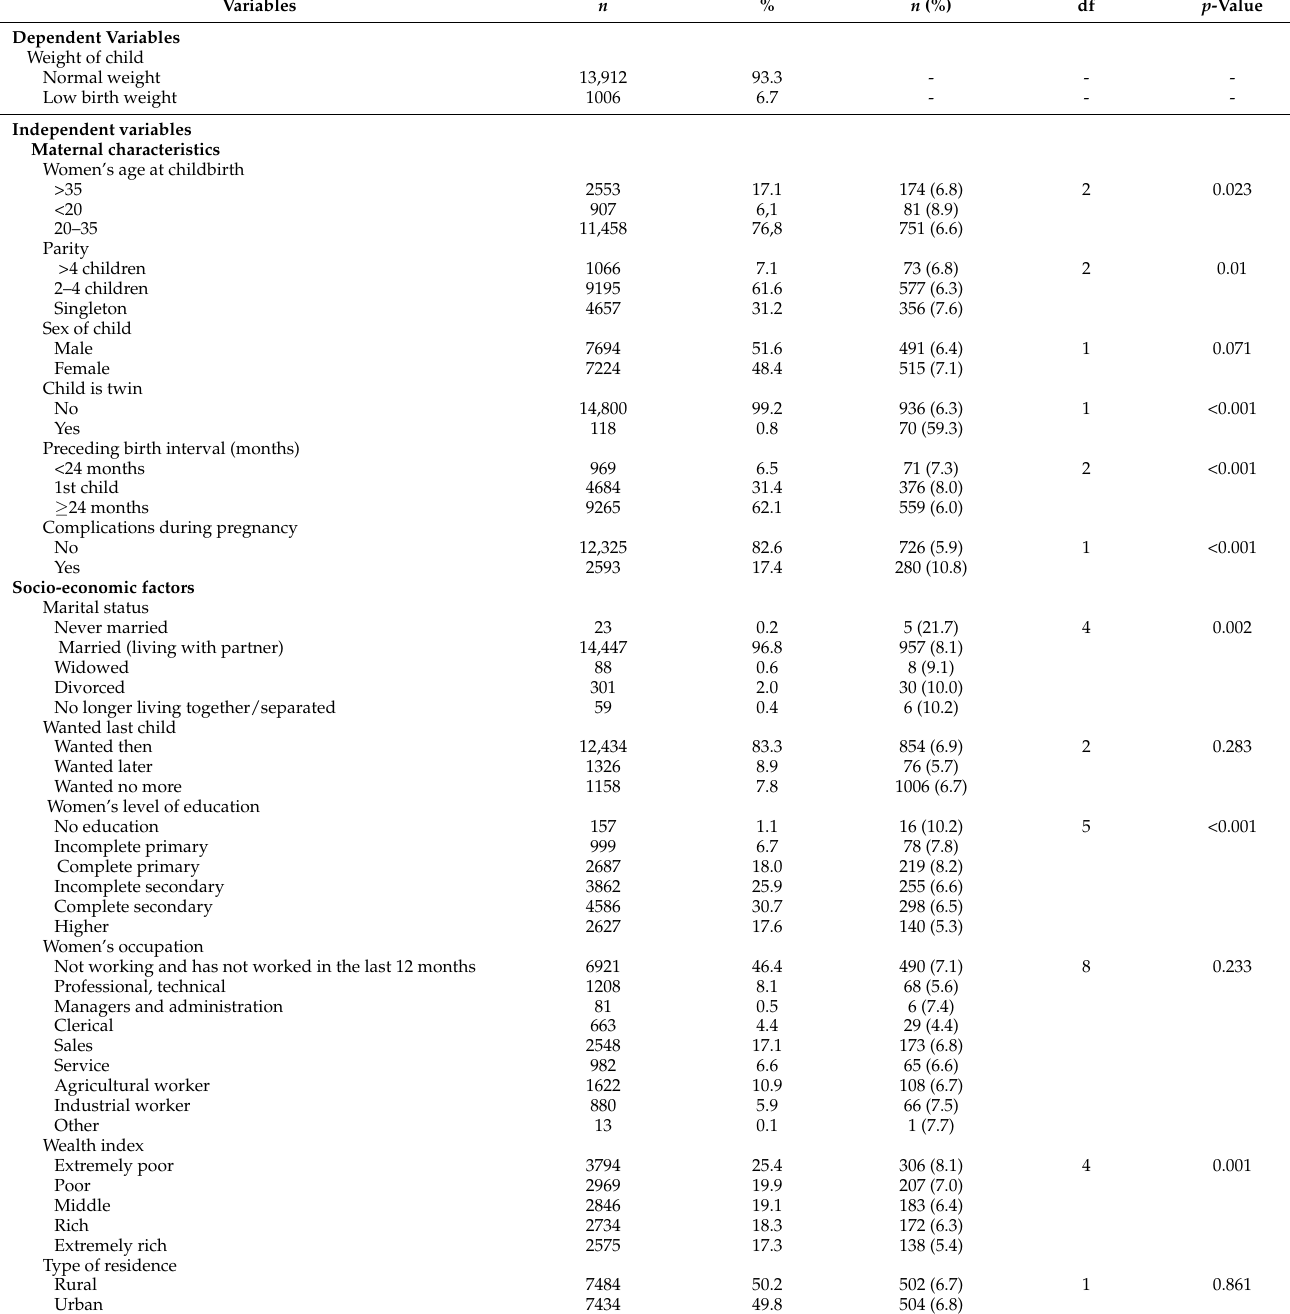
Table 1. Characteristics of 14,918 women aged 15–49 years with infants born within five years before 2017 IDHS and bivariate analysis of maternal characteristics and socio-economic factors with